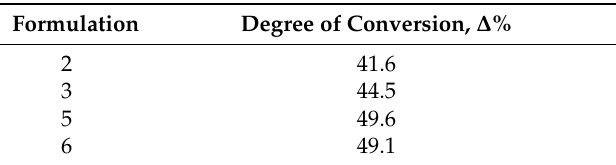
Table 3. Calculated DC values Formulation 2, 3, 5 and